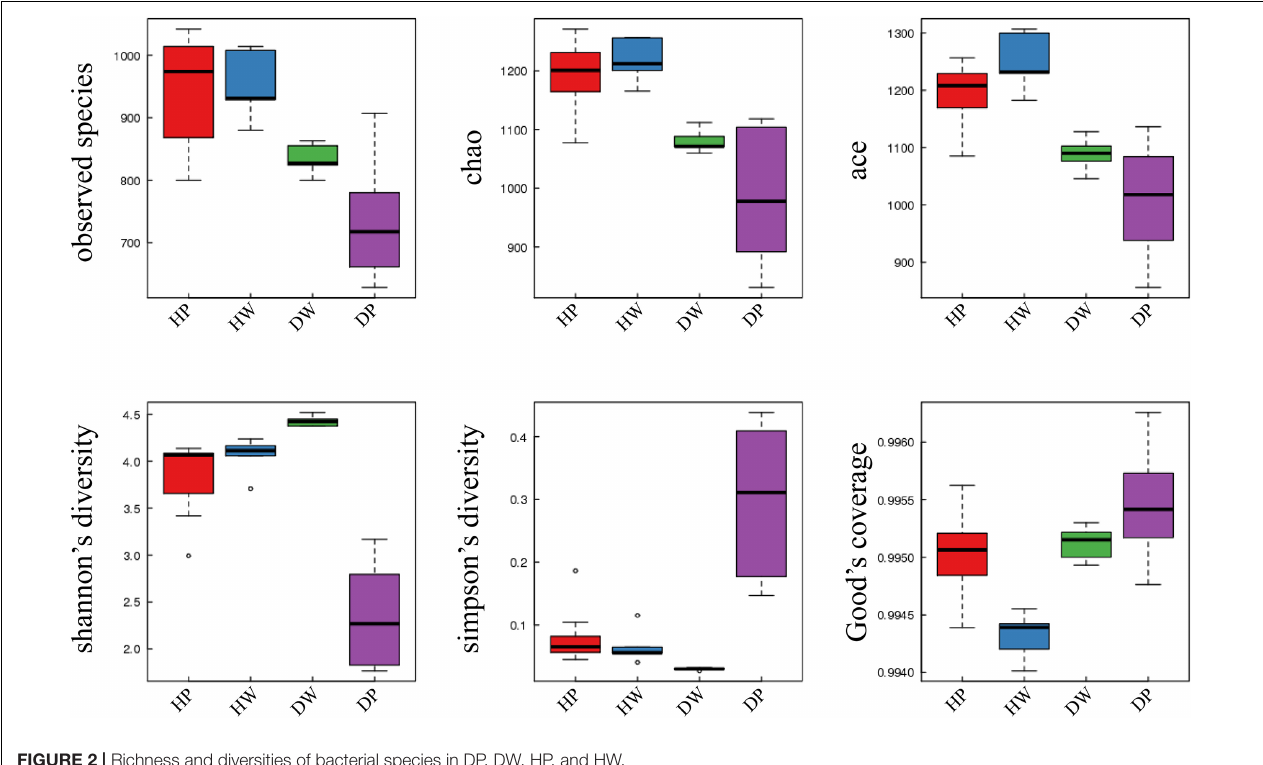
FIGURE 2 | Richness and diversities of bacterial species in DP, DW, HP, and HW.